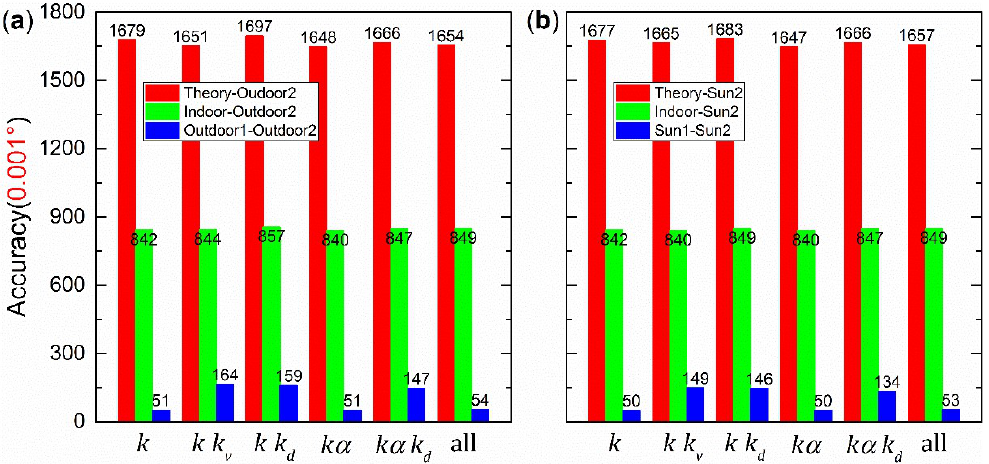
Figure 25. Outdoor replacement results when k was replaced: ( a ) The compensation is not done; ( b )